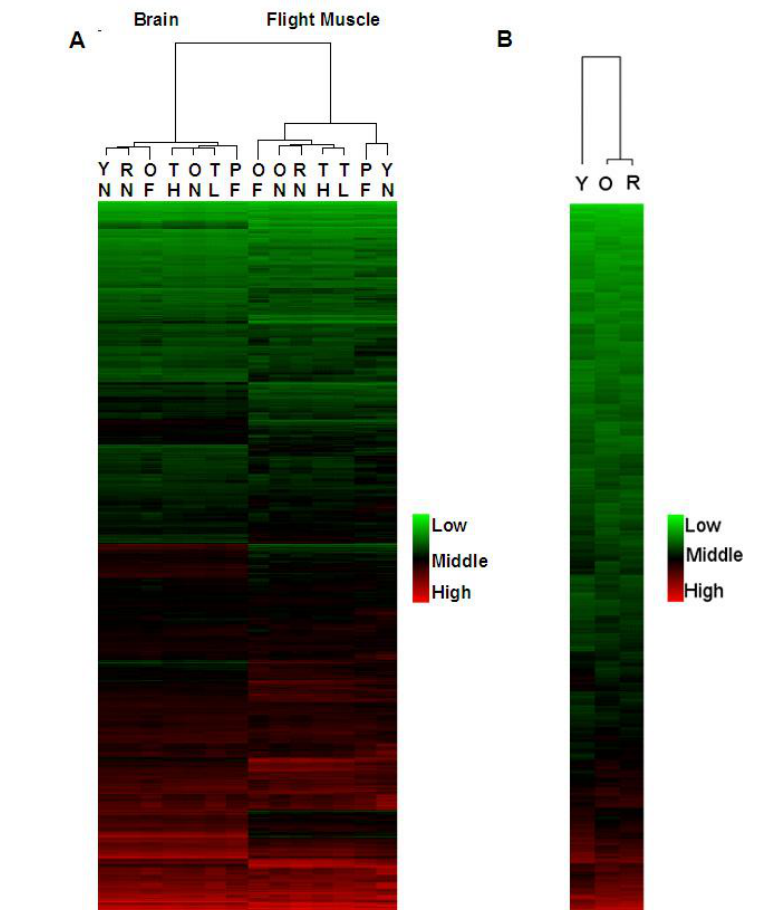
Figure 2. Global expression analysis. Hierarchical clustering was performed to visualize global patterns of gene expression. Replicates were averaged before analysis. Each graph represents over 12,000 transcripts and each row of the graphs represents one